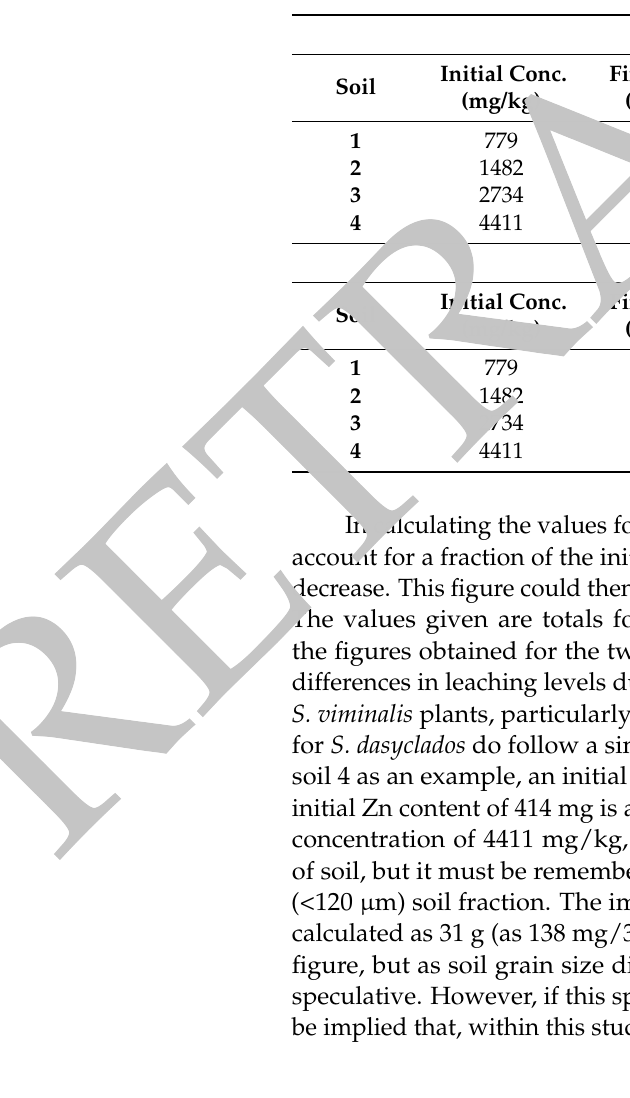
Table 11. Soil Zn concentrations (mg/kg). Initial and final values given for each soil along with decrease in Zn concentration expressed as a percentage, total extraction for each set of three plants (mg) and a calculated initial Zn content implied by these figures (mg).